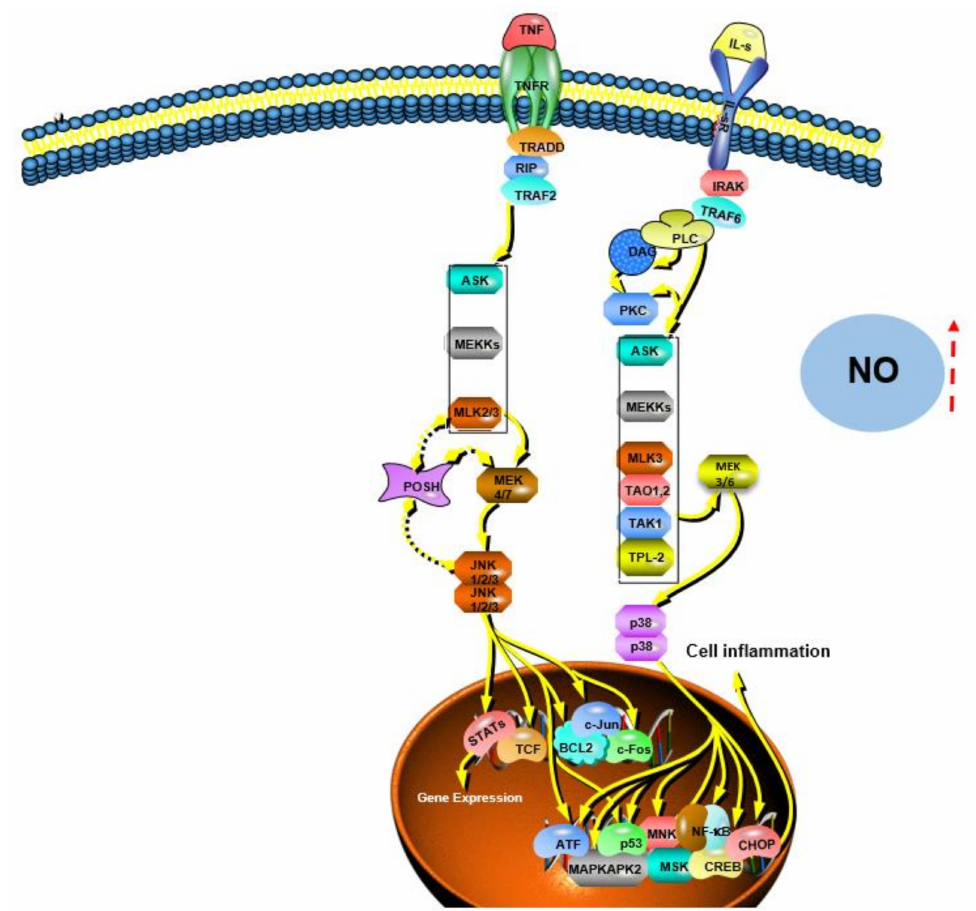
Figure 10. Immunomodulatory signaling mechanism of edible fungal polysaccharides in an in vitro cell model.